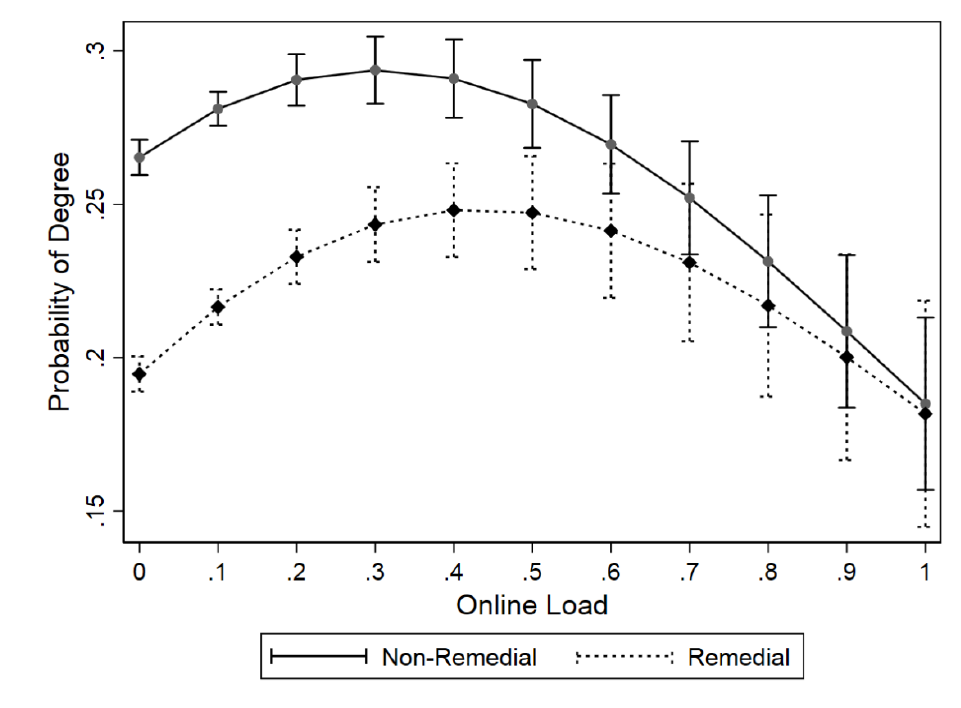
Figure 3 . Interaction between remedial status in fall 2012 and online